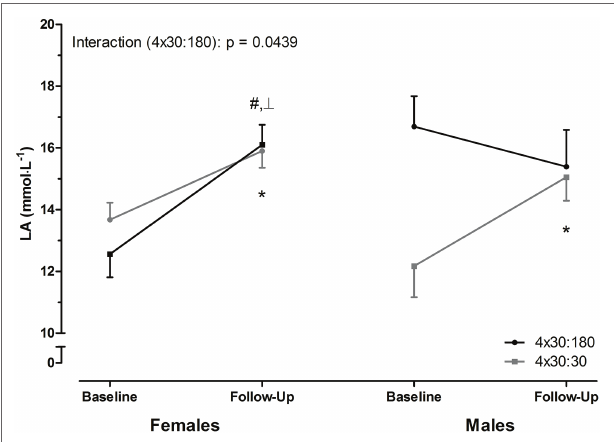
FIGURE 2 | Change in peak blood lactate (LA) concentrations by HIIT protocol. Peak LA concentrations were increased in response to the intervention for females in both groups. In males, peak LA concentrations changed only for the 4 × 30:30 group. Data are presented as mean ± SEM. ┴ significant interaction by two-way ANOVA for the 4 × 30:180 HIIT protocol. # p < 0.05, 4 × 30:180 group, baseline vs. follow-up; * p < 0.05, 4 × 30:30 group, baseline vs. follow-up by paired t